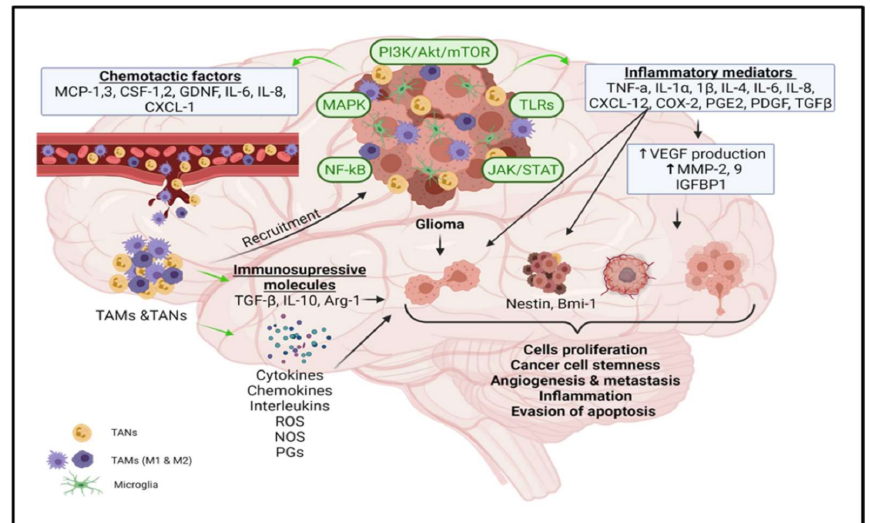
Figure 1. Represents tumorigenic role of inflammatory mediators, TAMs, TANs, and signaling pathways in glioma. Green color indicates activation/release. TAMs: tumor-associated macrophages; TANs: tumor-associated neutrophils; MCP-1,3: monocyte chemoattractant proteins-1,3; CSF-1,2: colony stimulating factors-1,2; GDNF: glial cell-derived neurotrophic factor; IL-1 α , β , -4, -6, -8, -10: interleukins-1 α , β , -4, -6, -8, -10; CXCL-1, -12; chemokine (C-X-C motif) ligand-1, -12; TNF- α : tumor necrosis factor- α ; COX-2: cyclooxygenase-2; PGE2: prostaglandin E2; PDGF: platelet-derived growth factor; TGF β : transforming growth factor β ; VEGF: vascular endothelial growth factor; MMP-2, 9: matrix metalloproteinases-2, 9; IGFBP1: insulin-like growth factor-binding protein 1; Bmi-1: B-cell specific Moloney murine virus integration site 1; Arg-1: arginase-1; NF- κ B: Nuclear factor kappa- light-chain-enhancer of activated B cells; JAK/STAT: Janus kinase-signal transducer and activator of transcription; MAPK: Mitogen-activated protein kinase; PI3K/Akt/mTOR: Phosphatidylinositol-3- kinase-mammalian target of rapamycin; TLRs: Toll-like